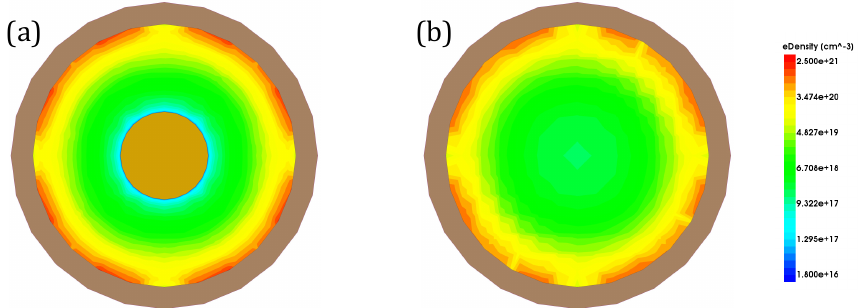
Figure 5. The electron density plot of CIGAA and GAA, the devices are at on state: ( a ) electron density of GAA; ( b ) electron density of CIGAA. Both figures are plotted when V GS = V DS , V DS = 1 V. Metal gate and part structures are not included in the figure for